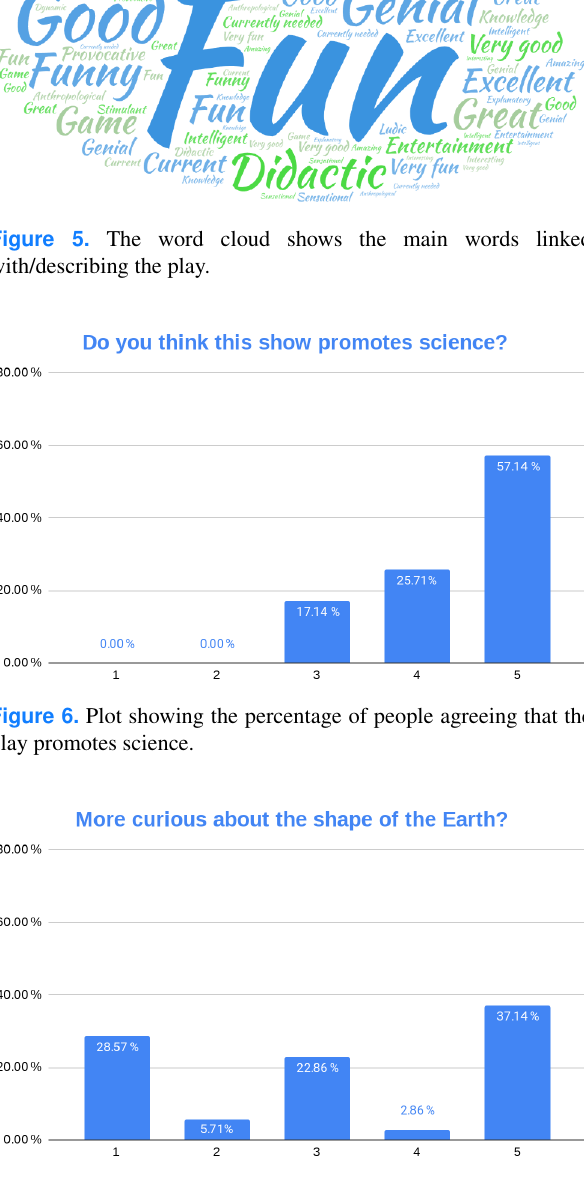
Figure 7. Plot showing the percentage of people more curious about the shape of the